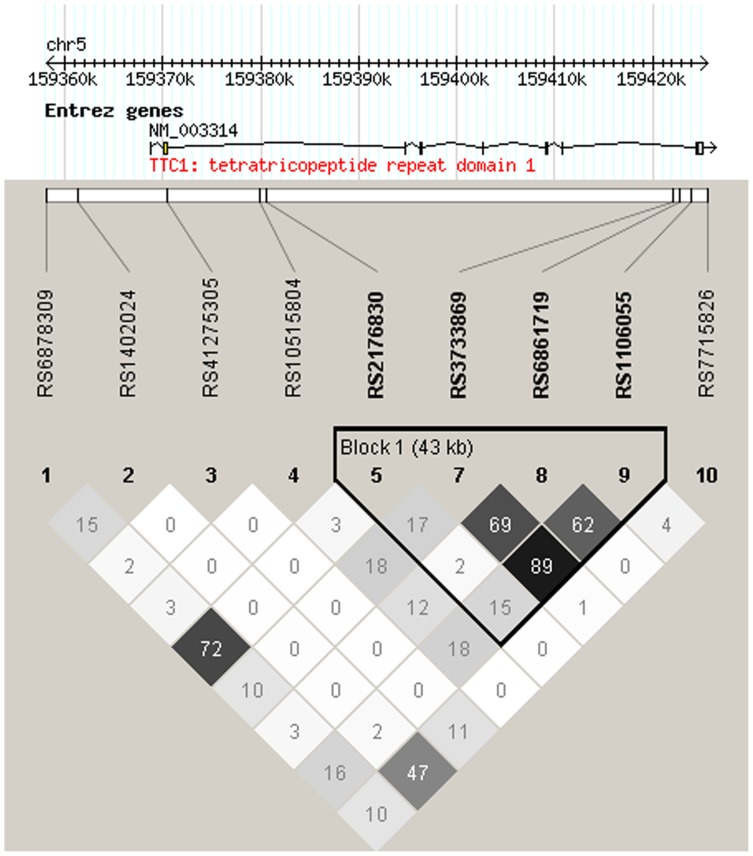
The analyzed TTC1 SNPs, their location and the haplotype block structure constructed using the Haploview program showing r2 values.